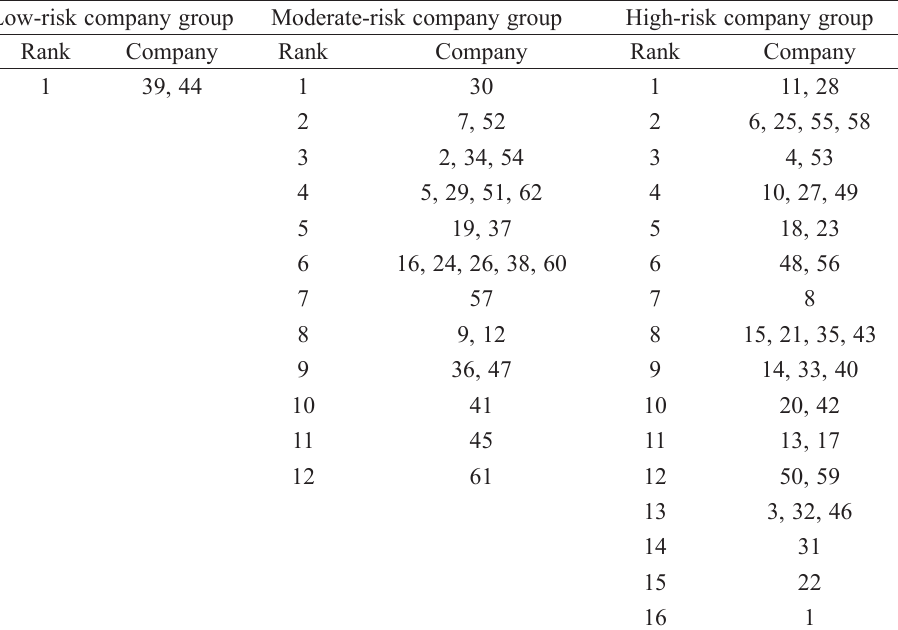
Table 7. The ranking of the companies by S , R and Q Low-risk company